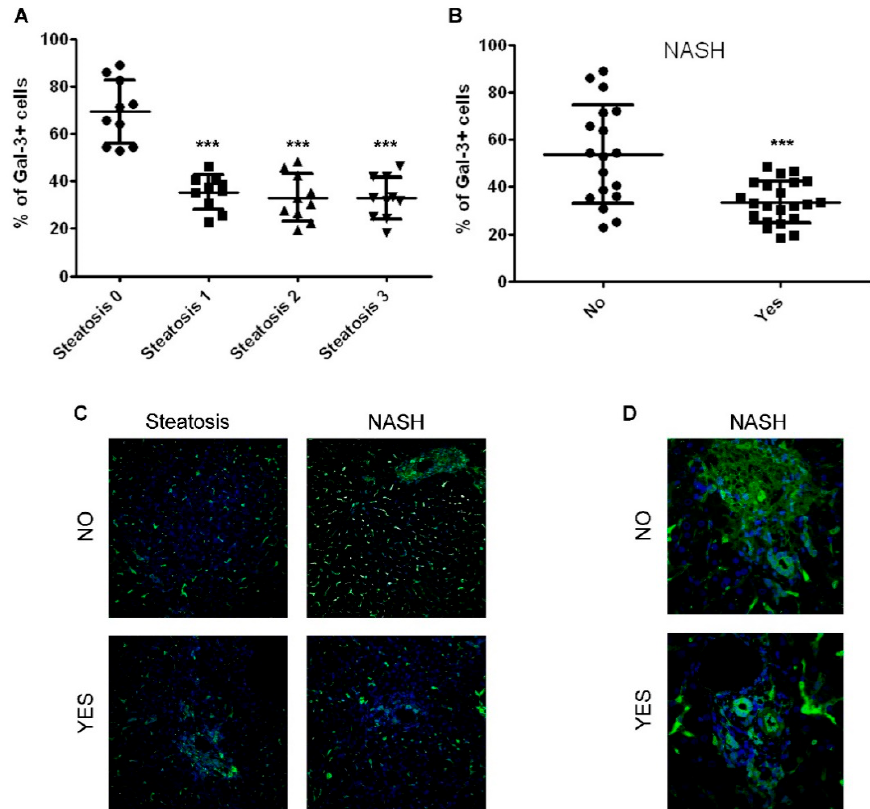
Figure 1. Analysis of the number of hepatic Gal-3 positive cells in children with NAFLD associated with the severity of disease. ( A , B ) Percentage of Gal-3 positive (Gal-3 + ) cells in the liver tissue from children with NAFLD correlated with degrees of steatosis ( A ) and the presence of NASH ( B ). *** p < 0.001 vs. steatosis 0 or no NASH. ( C ) Representative image of immunofluorescence of Gal-3 expression (green) in liver tissues from children with NAFLD showing the presence (Yes), or not (No), of steatosis and NASH. Magnification 20 × . ( D ) Representative image of immunofluorescence of Gal-3 expression (green) in liver tissues from children with NAFLD, which shows the presence or absence of NASH in portal and lobular compartments. Magnification 60 × . Nuclei were counteracted with Hoechst staining (blue).